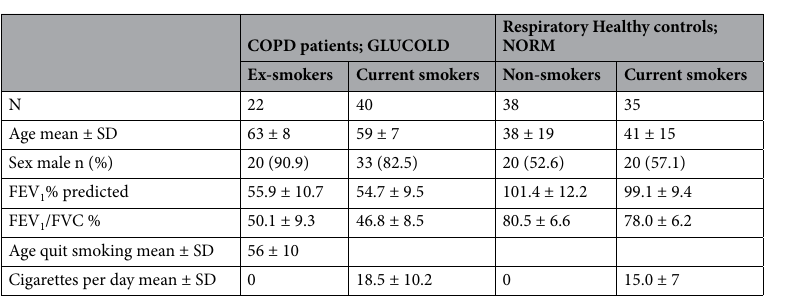
Figure 1. Flow diagram of the study approach. Two studies were used: the GLUCOLD study with current or ex-smoker COPD patients and the NORM study with current or non-smoking respiratory healthy controls. A linear regression model was used to identify smoking-associated miRNAs. The overlapping two miRNAs were used for further analysis of COPD patients. A meta-analysis of Pearson correlations was performed to identify miRNA associated mRNA. The predicted targets were obtained, and a list of negatively correlated predicted targets was compiled. Pathway analysis was performed using this list as well as on all the negative and positively correlated mRNAs. Negatively correlated predicted targets were repeated in the NORM. Additionally, miRNA expression was correlated to cell type signatures and cell populations.